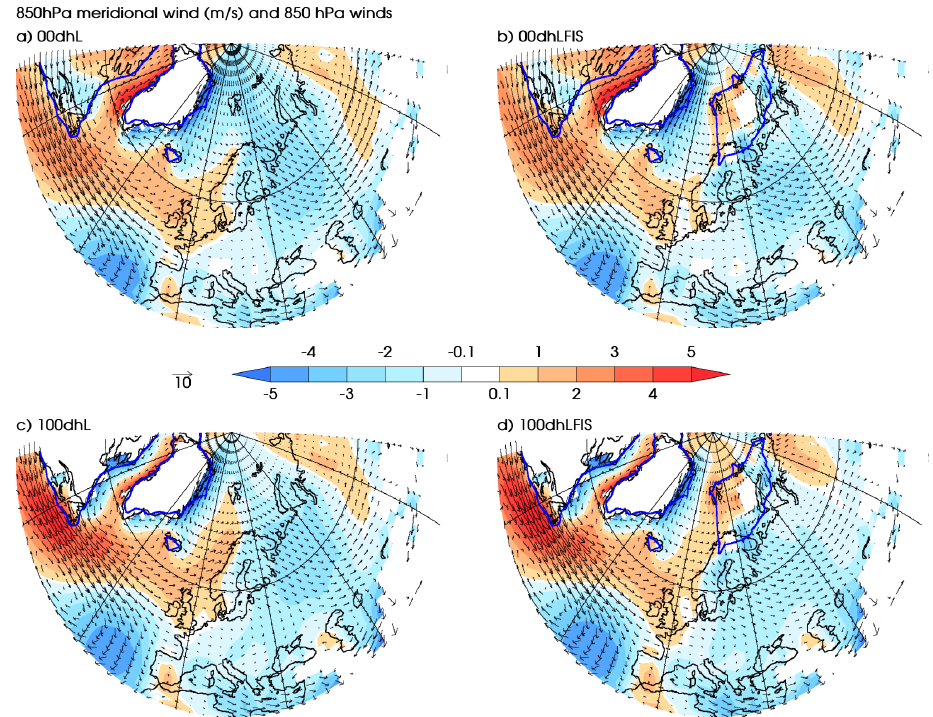
Figure 16. Same as Fig. 14 for the 850hPa meridional wind (shaded) and the 850hPa horizontal winds (arrows) for the summer season (in ms − 1